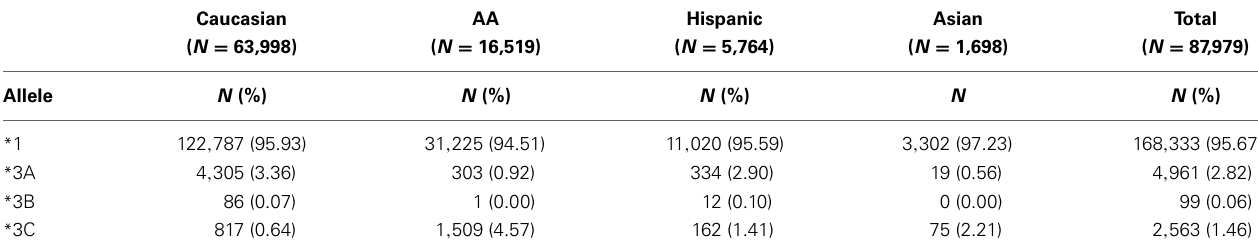
Table 3 | Distribution of genotypes for TPMT alleles *3A, *3B, and *3C across the different ethnic groups. Caucasian AA